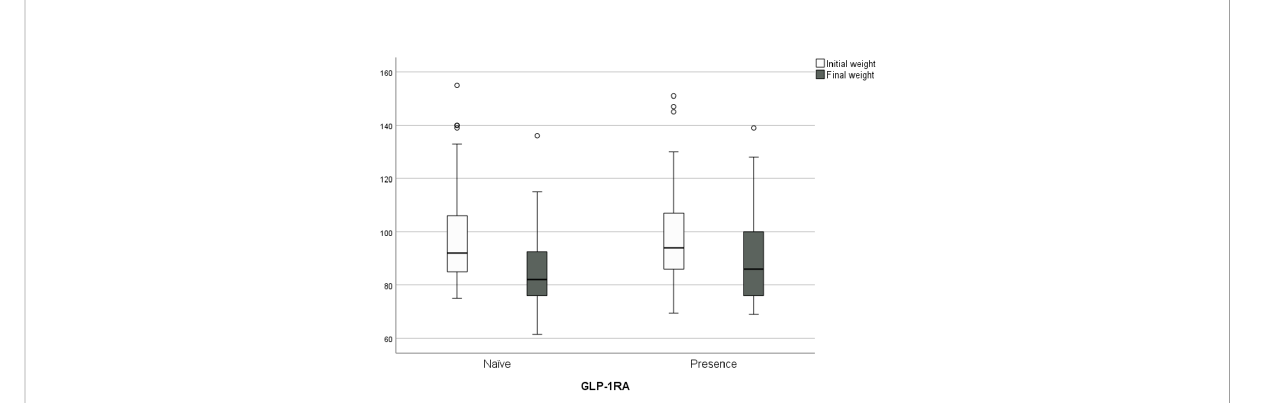
FIGURE 3 Change in body weight from baseline to the end of study (-9.72 ± 9.7 kg) (from 98.48 ± 16.6 kg to 88.76 ± 16.42 kg; p<0.001). Weight loss was greater for GLP- 1RA- naïve people (-12.42 ± 9.1 kg vs. -7.65 ± 9.7 kg;